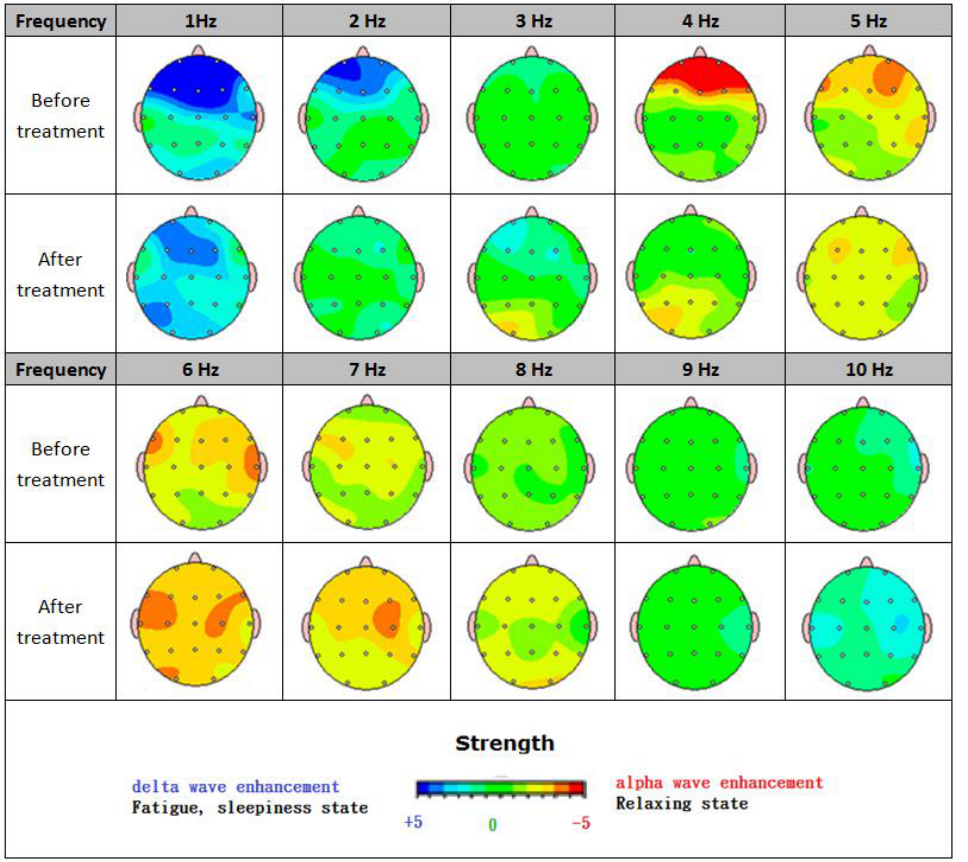
Figure 12. BEAM comparison between before and after